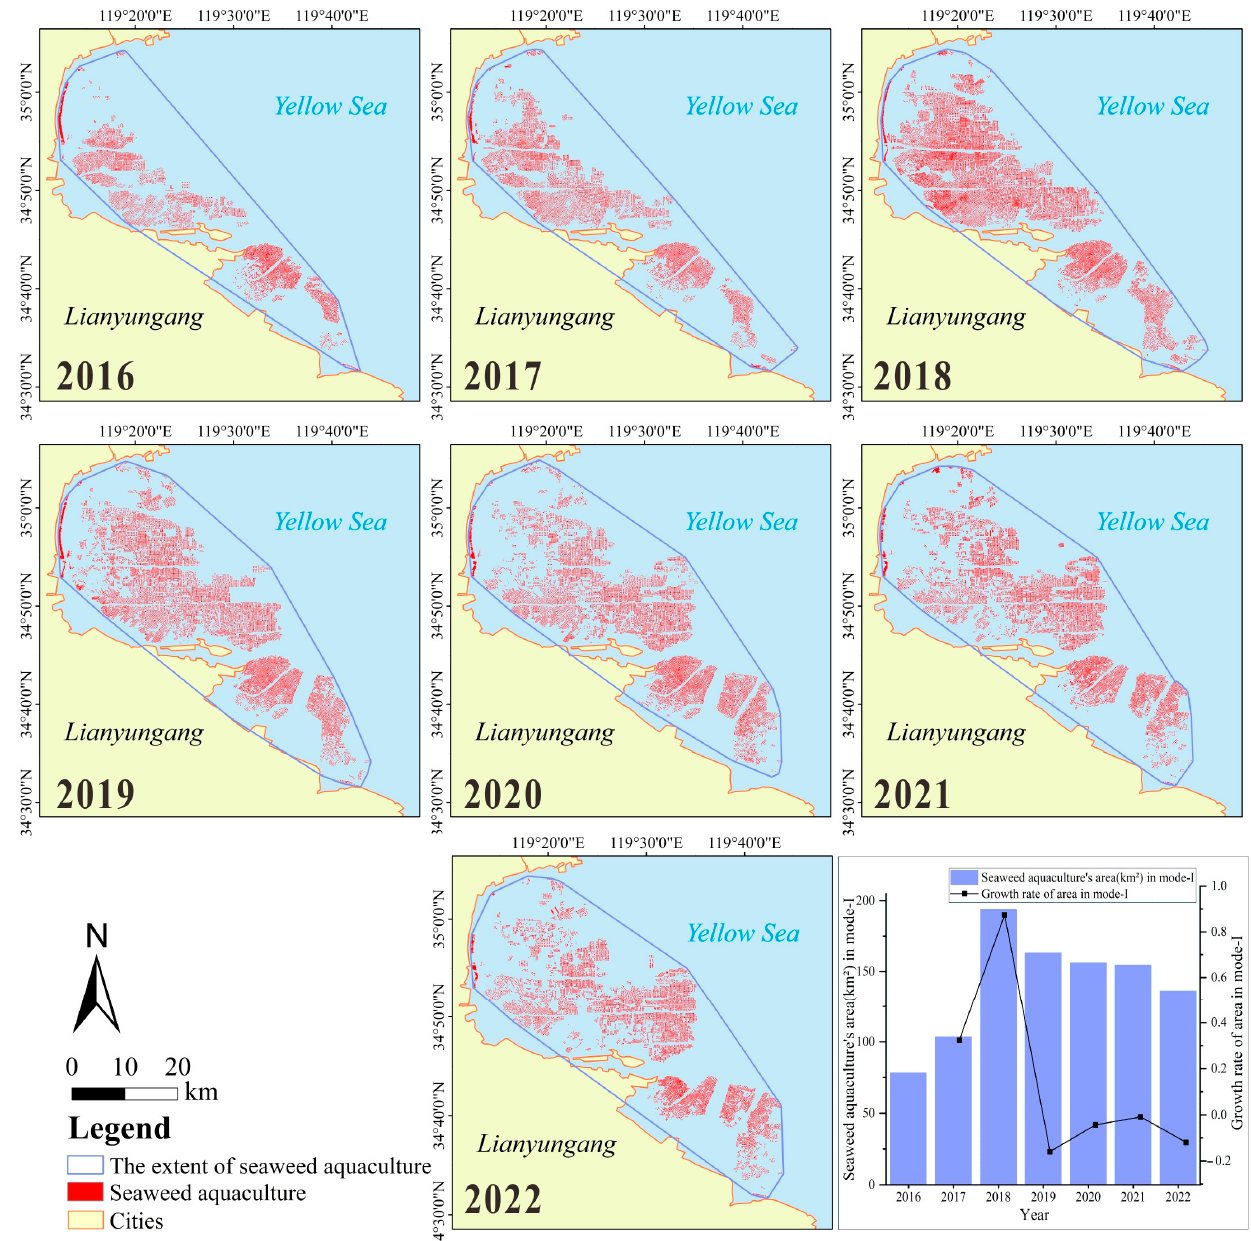
Figure 5. Spatiotemporal dynamics of seaweed aquaculture in mode-I (2016–2022).